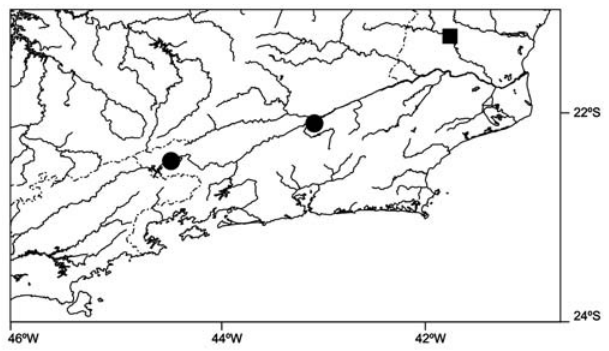
Fig. 6. Paraíba do Sul drainage illustrating collecting locali- ties of Parotocinclus bidentatus (circles, type locality on the left) and P. muriaensis (squares). Each symbol may present more than one sample or